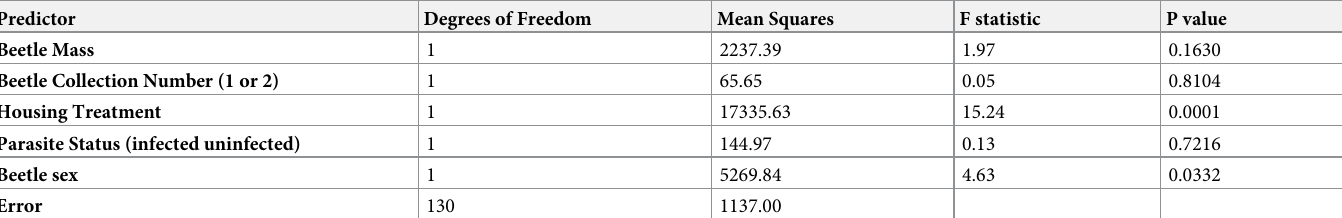
Table 3. Summary of general linear model that examined predictors of acoustic emission rates (during simulated attack) in horned passalus beetles in this experi- ment. An interaction term between parasitism and housing treatment was not significant in a preliminary model (Davis, unpubl . data ). Predictor